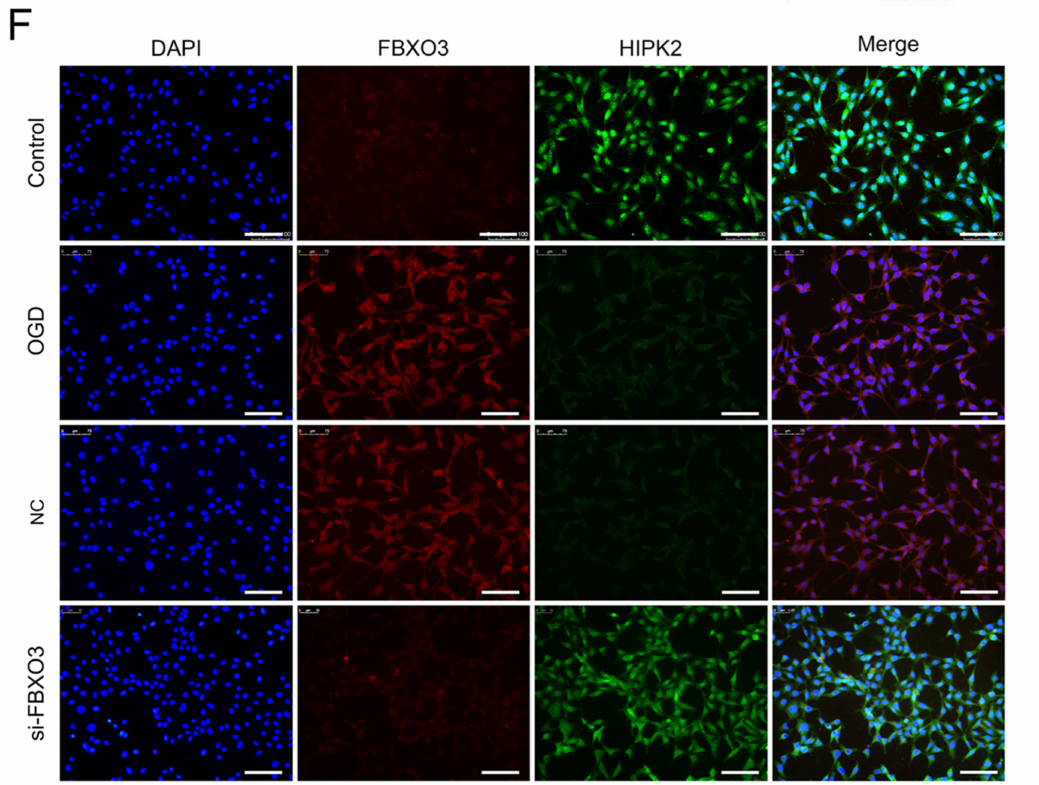
Figure 6. FBXO3 facilitated inflammation probably through binding and degrading HIPK2 in HT22 cells after OGD/R stimulation. ( A , C ) WB analysis of HIPK2 in HT22 cells at OGD4 h/R 24 h with or without siRNA treatment. ( B , D ) WB analysis of HIPK2 in HT22 cells at OGD4 h/R 24 h with DMSO or BC-1215 treatment. ( E ) Co-Immunoprecipitation (Co-IP) analysis of FBXO3 and HIPK2 in HT22 cells. ( F ) Representative immunofluorescence images (200 × , scale bar = 100 µ m) of FBXO3 (red) and HIPK2 (green) in HT22 cells at OGD4 h/R 24 h with or without siRNA treatment. Statistics for each group are expressed as mean ± SD ( n ≥ 6). * p < 0.05 (values in Control group versus MCAO group), # p < 0.05 (values in NC group versus si-FBXO3 group), && p < 0.01 (values in DMSO group versus BC-1215